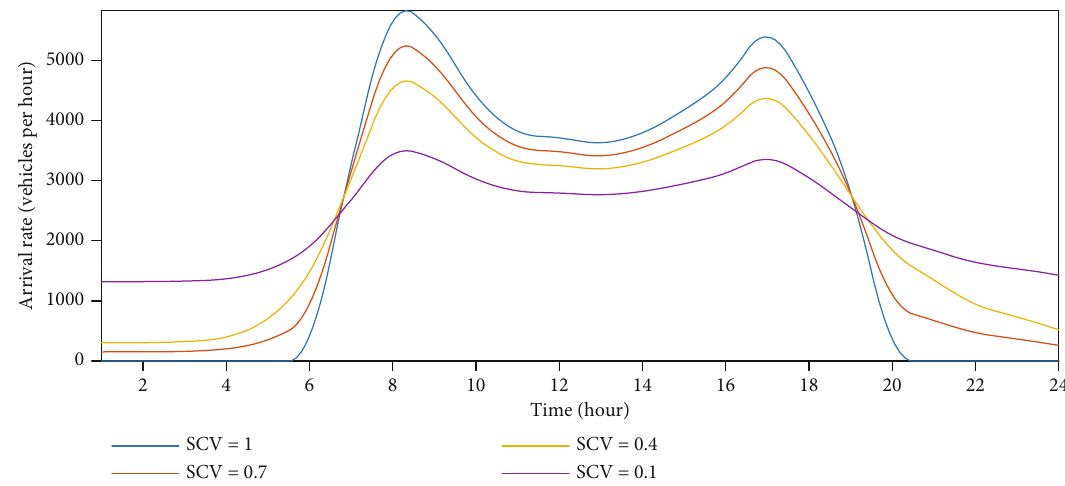
Figure 2: Varying arrival rates for the low tra ffi c